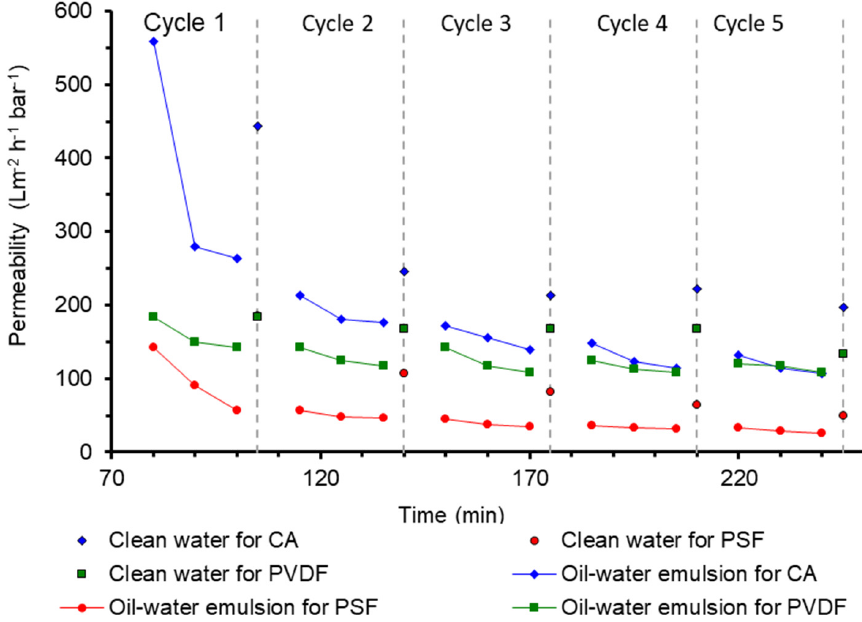
Figure 8. The permeability of the cellulose acetate (CA), polysulfone (PSF), and polyvinylidene difluoride (PVDF) membranes for five cycles in 30 min of oil/water emulsion and 5 min in clean water as a function of filtration time.